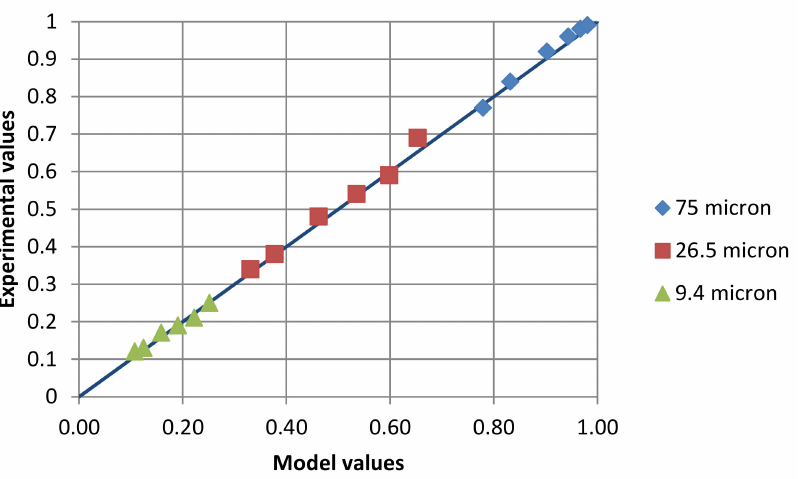
Figure 7. The slope of the straight line in this figure is 1, passing through 0, and there is very little scatter for the selected particle sieve sizes.